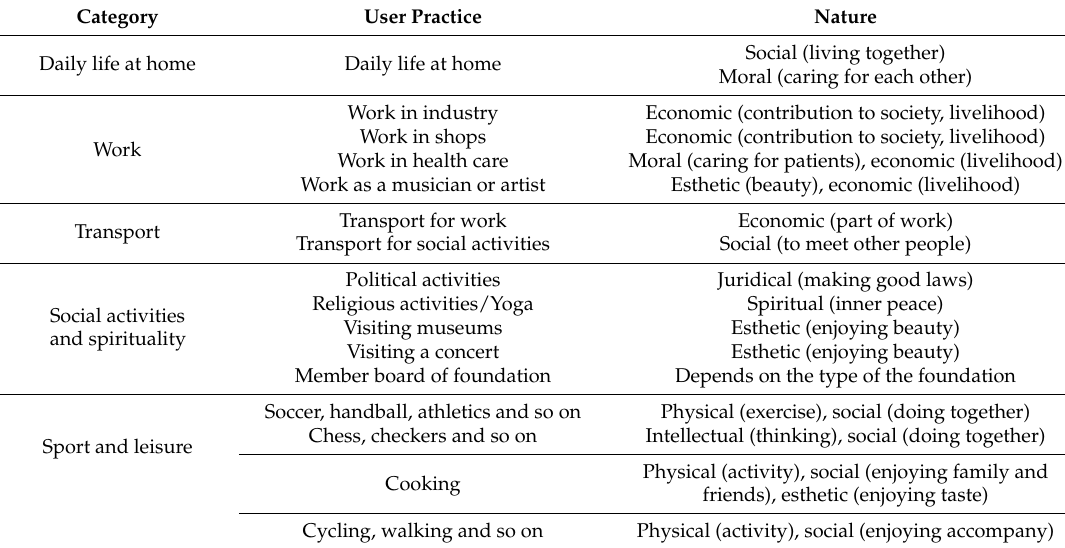
Table 2. Overview of different natures of user practices from the perspective of meaning-making. Category Daily life at